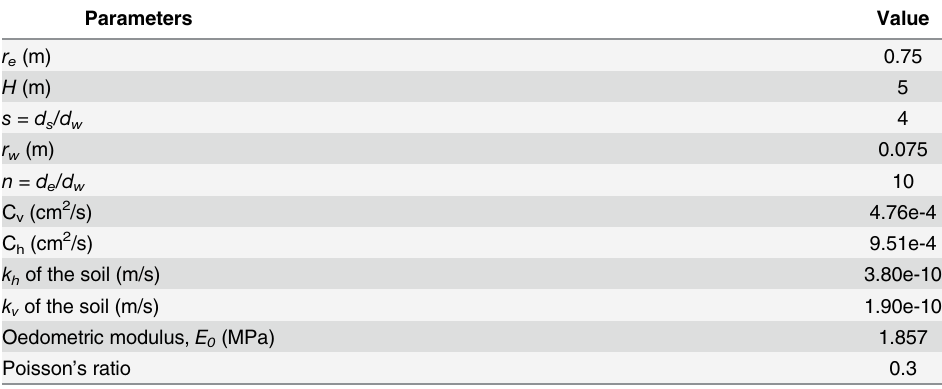
Table 1. Parameters used in the analytical solution and the numerical model.